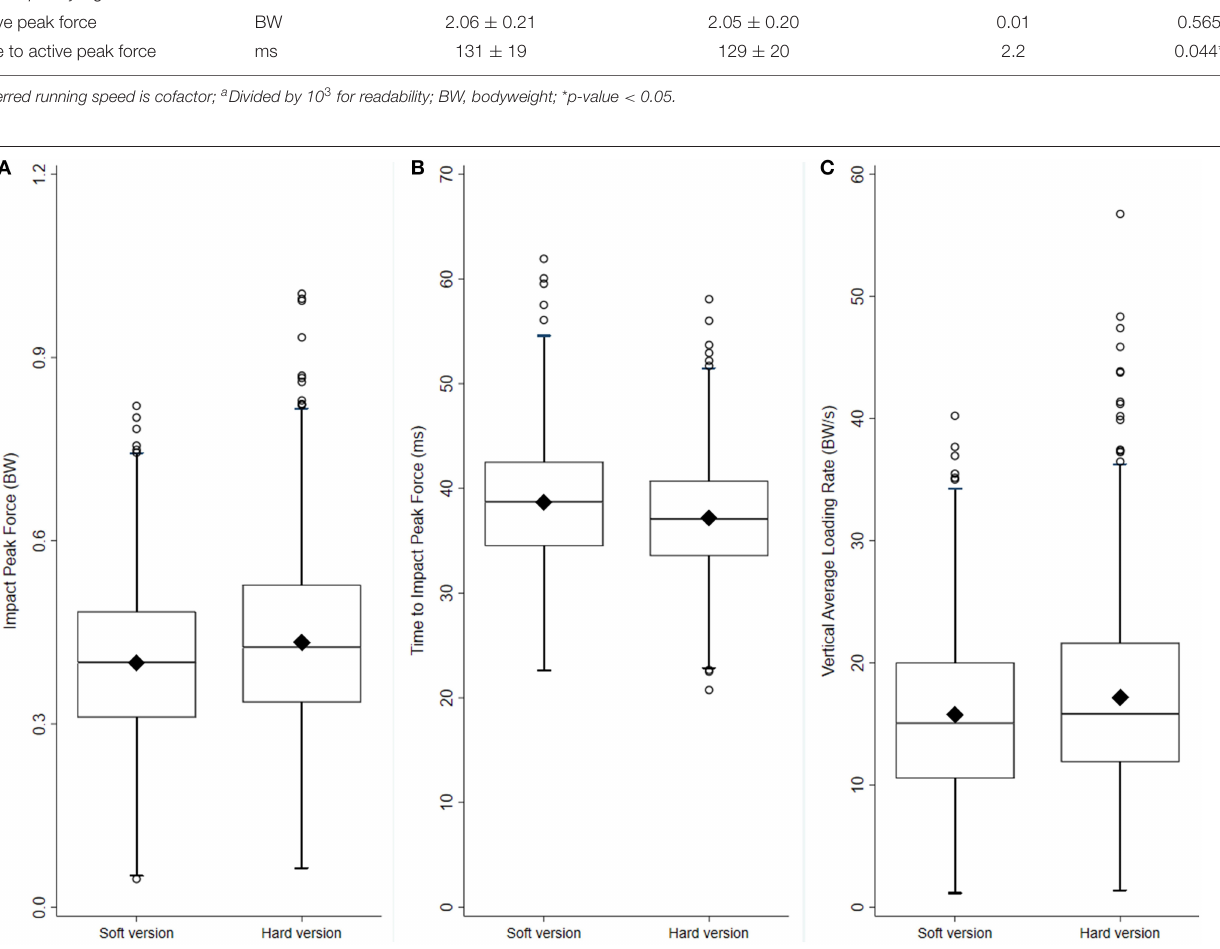
FIGURE 4 | Box plots for impact peak force [BW, p < 0.001, (A) ], time to impact peak force [ms, p < 0.001, (B) ] and vertical average loading rate [BW.s − 1 , p = 0.006, panel (C) ] of the high frequency signal, in the two experimental groups ( n = 428 and 420 for the Soft and Hard shoe group, respectively). The lower and upper box boundaries indicate the 25th and 75th percentiles, respectively, the middle line inside the box represents the median, and the filled diamond is the mean. Whiskers below and above the boxes represent the 25th percentile − 1.5*interquartile range (IQR) and 75th percentile + 1.5*IQR, respectively. Empty circles are data falling outside the range of the